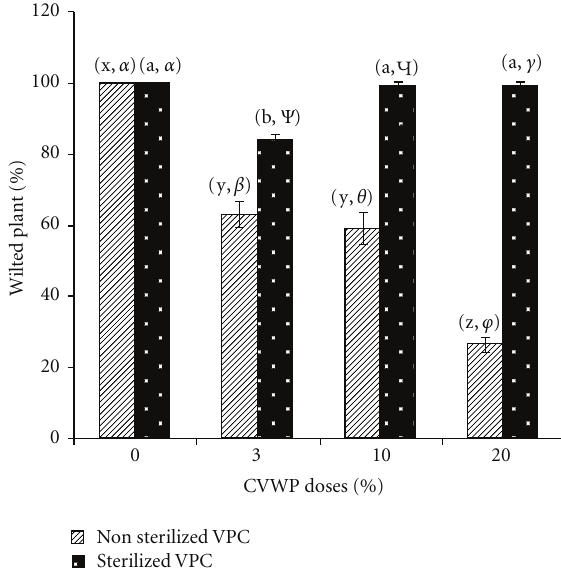
Figure 3: Newman’s keuls test di ff erences were assessed at P < 0 . 05. Sampling unit for statistical analysis is the pot, not the plant. (a, b, x, y and z) means the comparison between doses of VPC and ( α , β , Ψ , θ , Q , ϕ and γ ) means di ff erences between sterilized and no sterilized VPC.